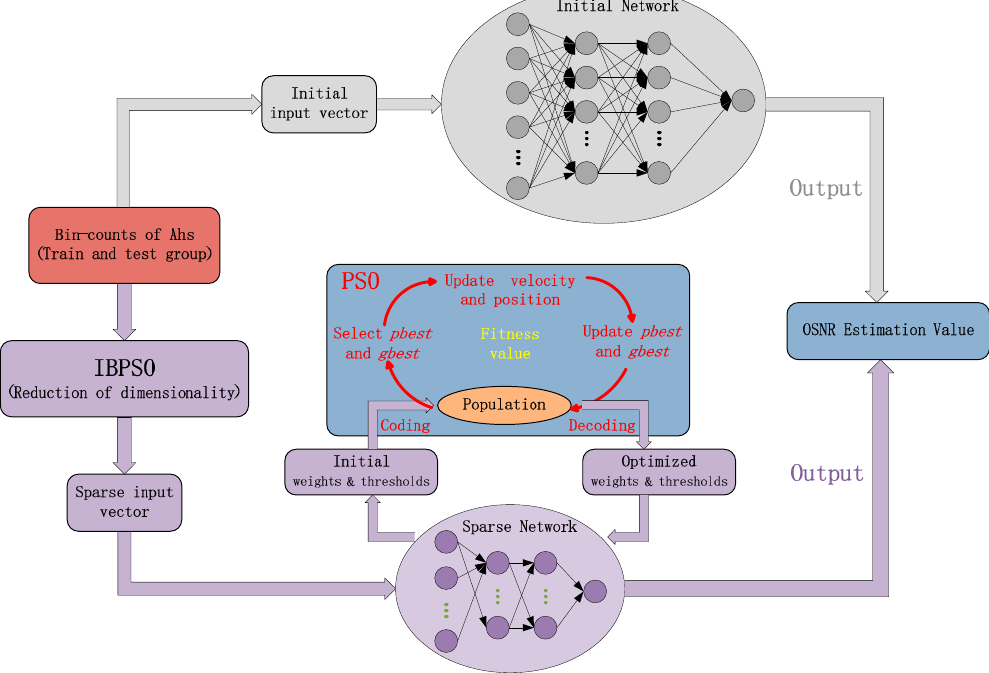
Figure 6. Process of deep neural network (DNN) optimized by IBPSO.